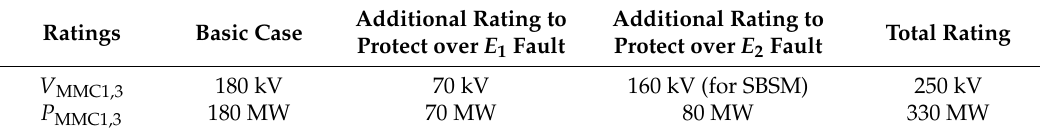
Table 3. Power and voltage ratings of MMC1, 3 in the simulated DUDAT.